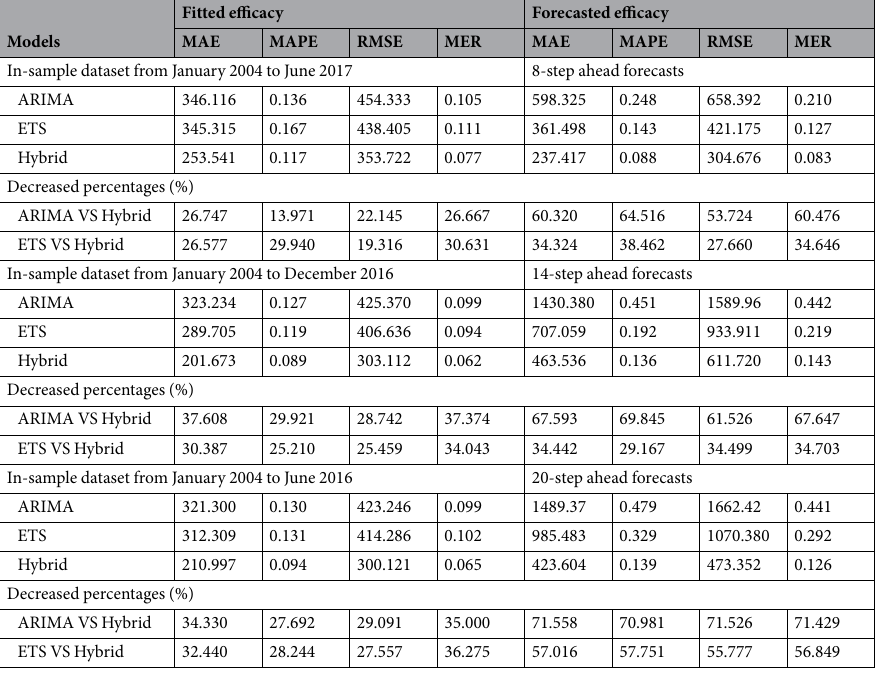
Table 3. Comparison results of in-sample fitting and out-of-sample forecasting performance for the selected